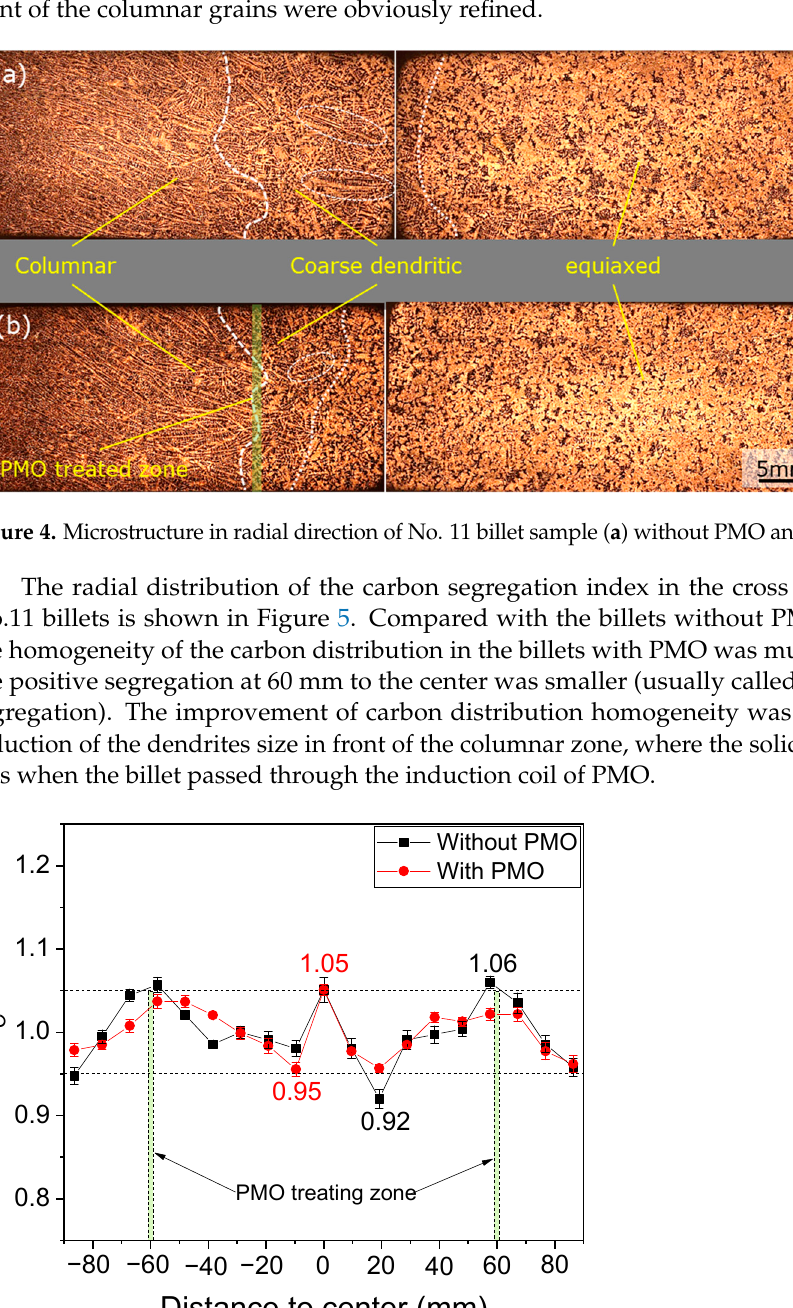
Figure 3. Macrostructure on cross section of low-alloy steel S4 (No. 11) round billet ( a ) without PMO and ( b ) with PMO.